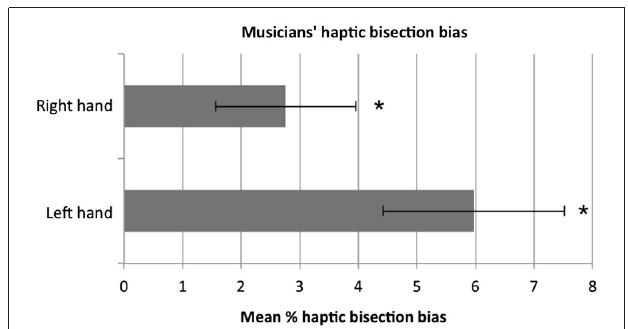
FIGURE 1 | The mean percentage bisection bias in musicians . Participants showed a significant rightward bias (minineglect) both with the left and with the right hand. The tendency to bisect to the right was stronger with the left than with the right hand, although not to a significant extent ( p = 0.081). Error bars represent ± 1 SEM. Asterisks indicate that the bias was significantly different from zero (i.e., true midline, absence of bias).